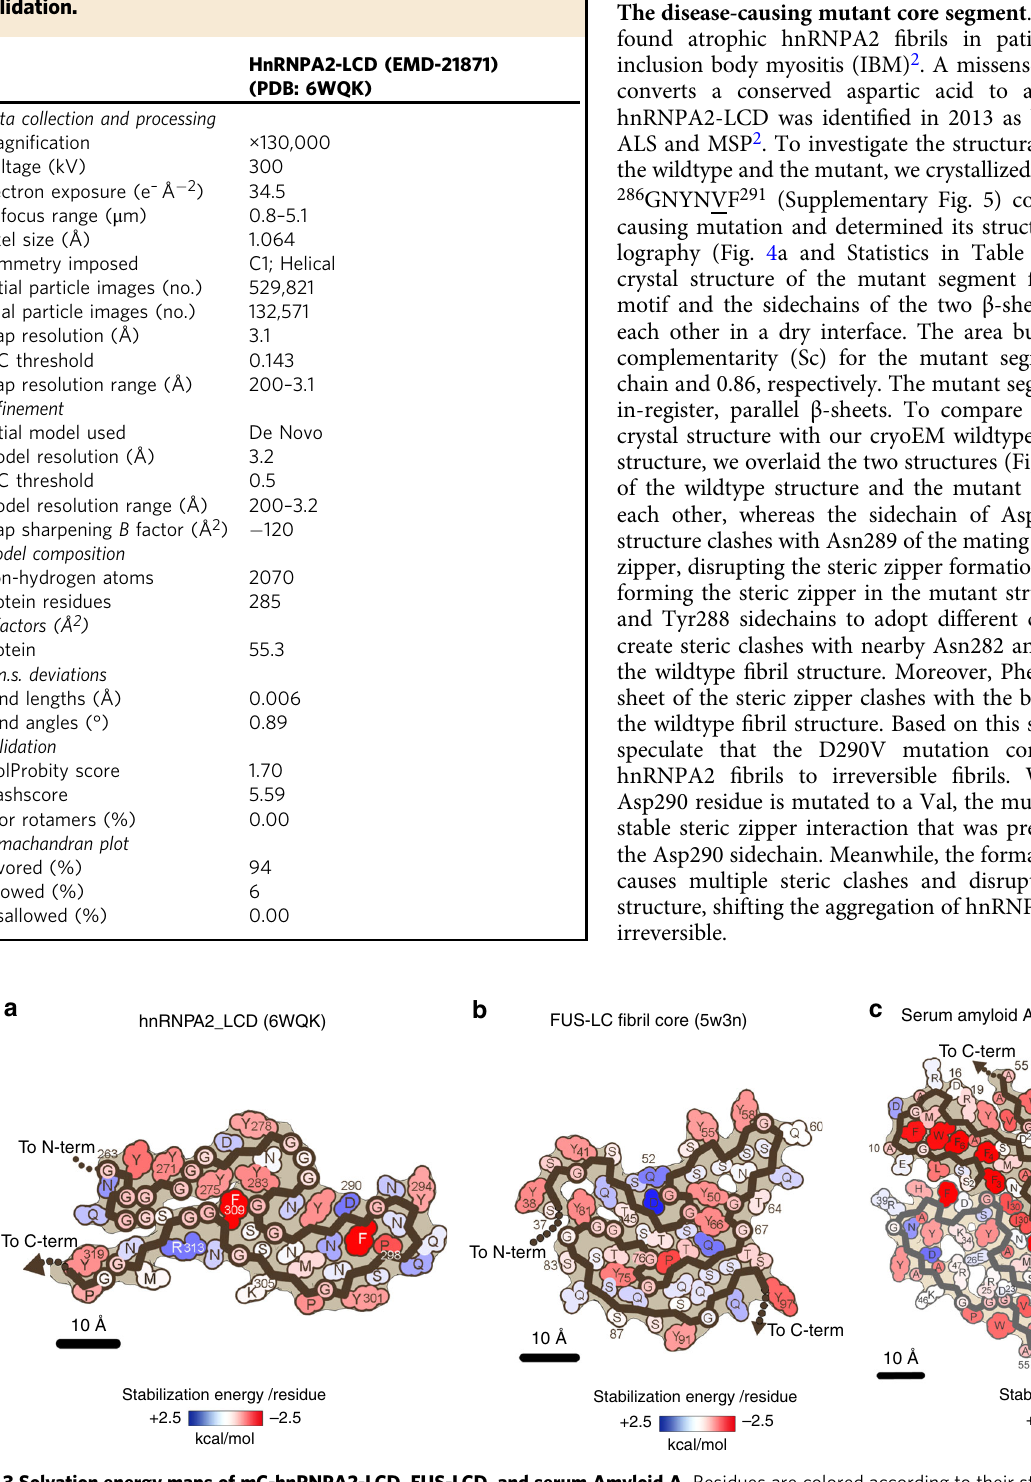
Fig. 3 Solvation energy maps of mC-hnRNPA2-LCD, FUS-LCD, and serum Amyloid A. Residues are colored according to their stabilization energies from unfavorable (blue, + 2.5 kcal mol − 1 ) to favorable (red, − 2.5 kcal mol − 1 ). a Solvation energy map of mC-hnRNPA2-LCD ordered fi bril core. b Solvation energy map of FUS-LCD 14 ordered region. c Solvation energy map of human serum amyloid A 19 , ordered